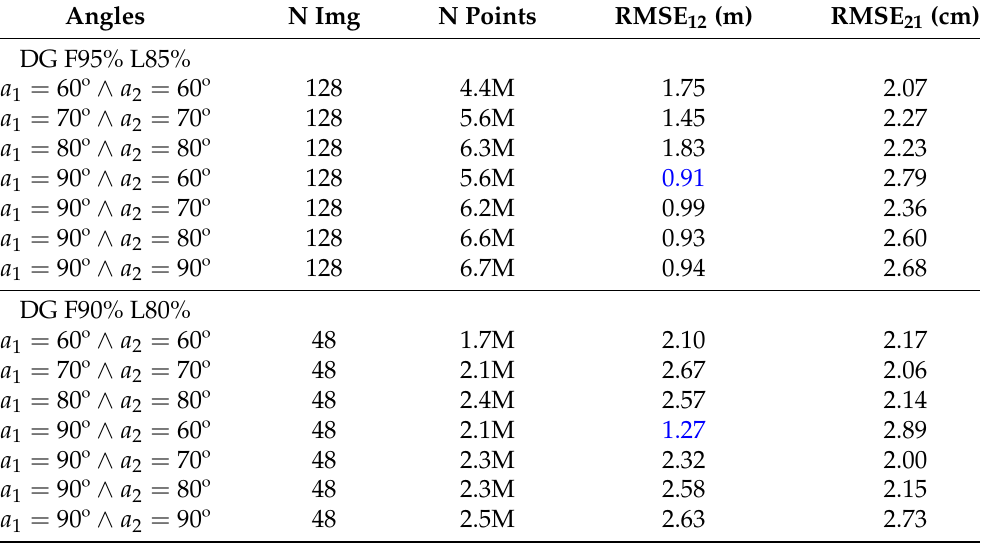
Table 3. Quality metrics for different camera angles in a double grid setup. Blue values represent the best result for each configuration.